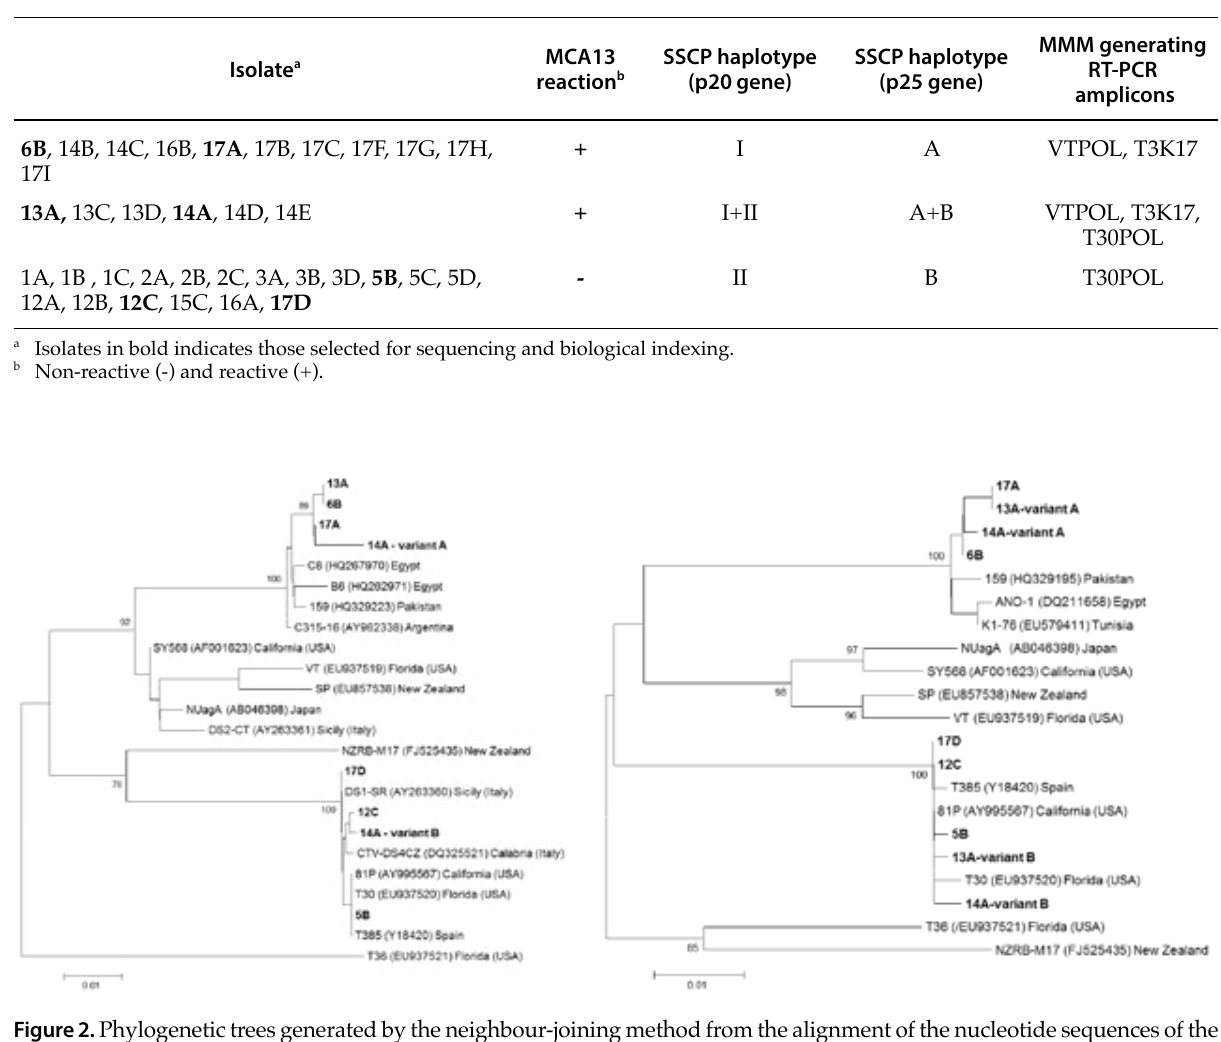
Table 2. Serological and molecular features of Citrus tristeza virus isolates recovered in Calabria.